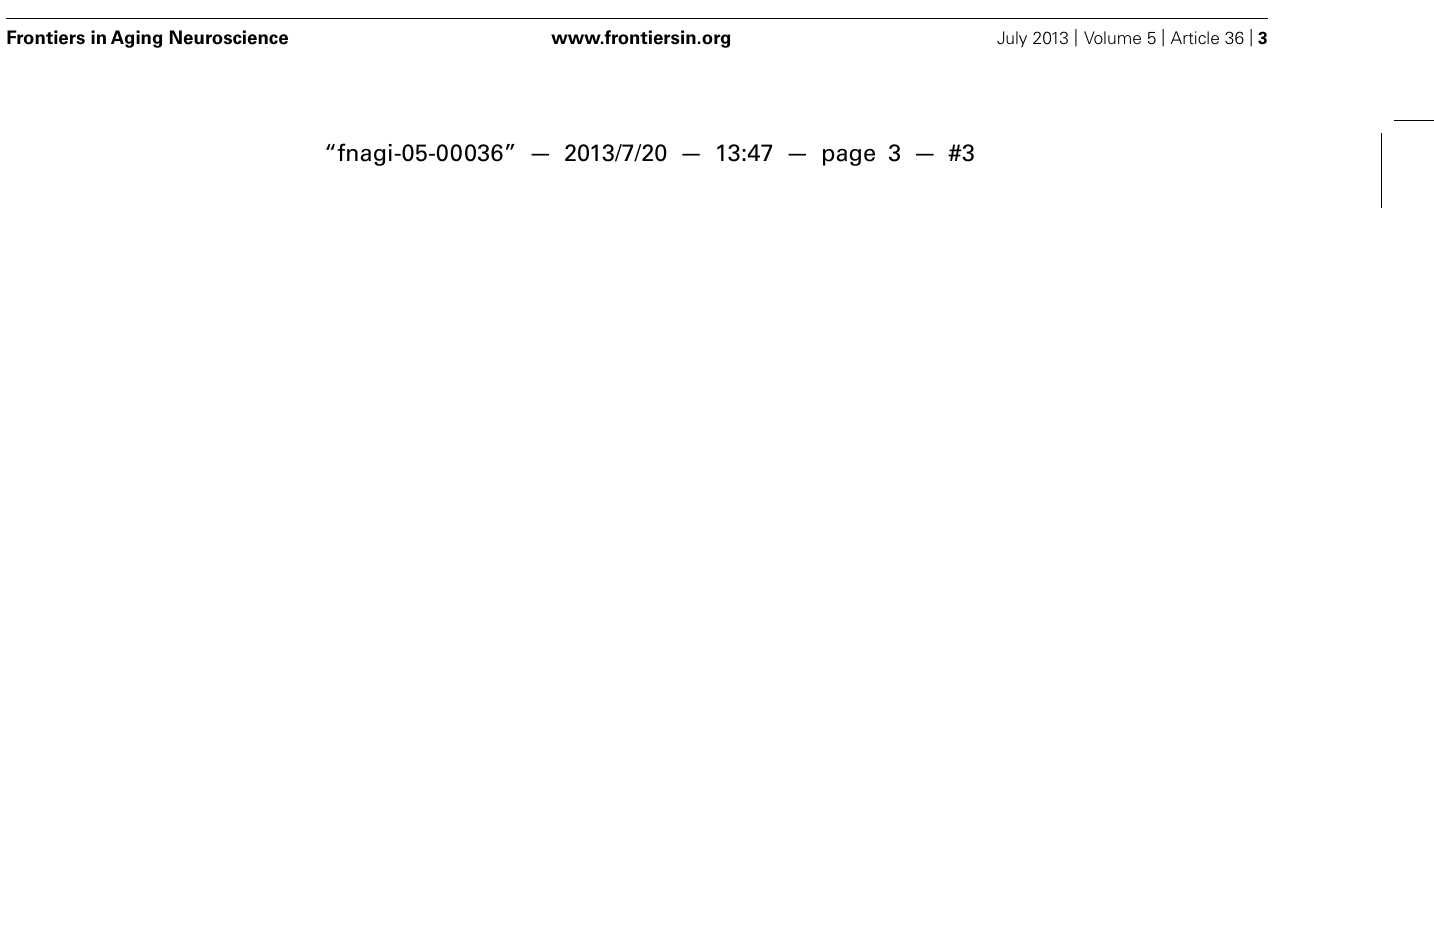
non-histone molecules, and improve genome stability, prevent apoptosis and inflammation, and increases mitochondrial biogenesis, insulin sensitivity and glucose tolerance. All these effects result in